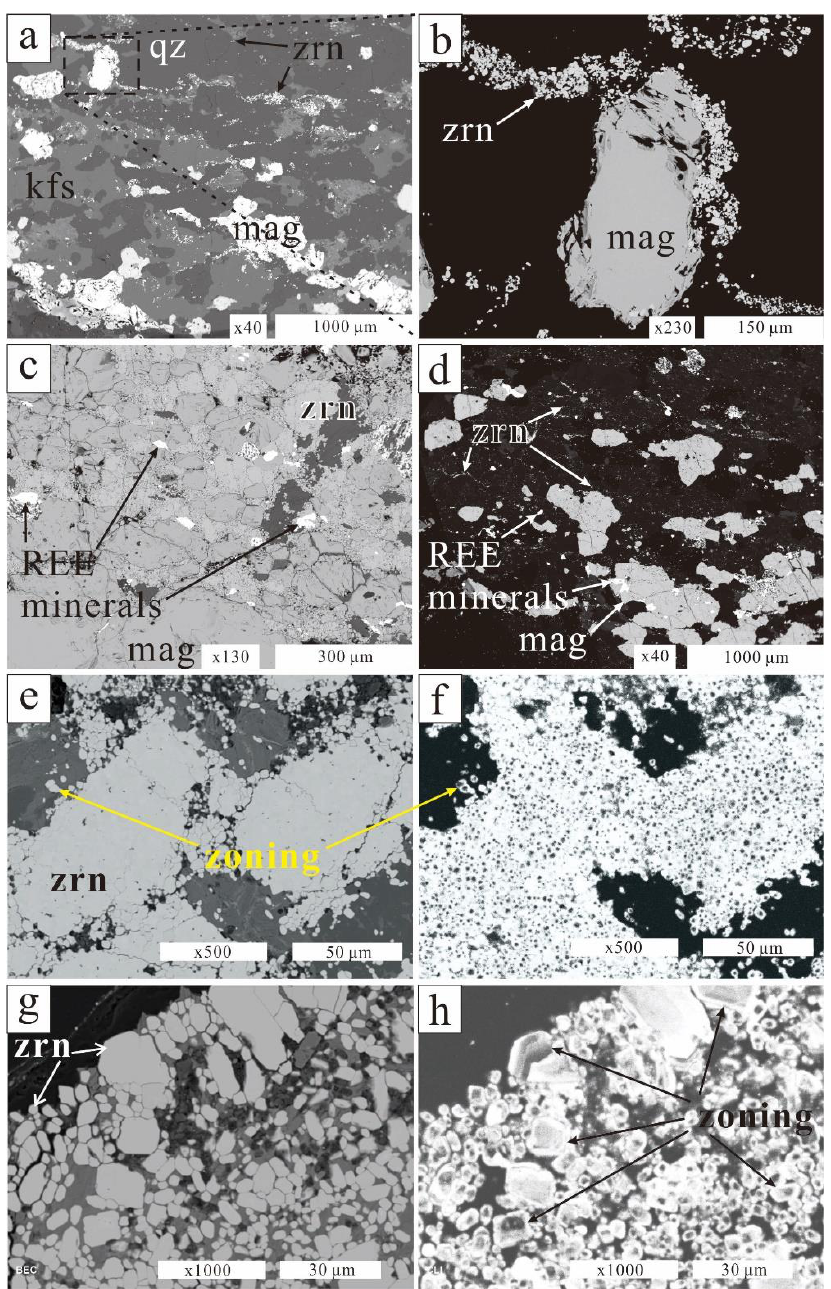
Figure 6. Photomicrographs of zircon aggregate from zircon–allanite–magnetite-rich layers in layered granite and layered aplite. ( a , b ) Back-scattered electron (BSE) images of the zircon–allanite–magnetite layer from layered granite. Note that aggregates of zircon showed crystal settling textures upon magnetite, quartz, and K-feldspar grains. ( c ) BSE image of a zircon–allanite–magnetite-rich layer in layered granite. ( d ) BSE image of alkali aplite showing a linear distribution of zircon grains. ( e ) BSE image of zircon aggregates in a zircon–allanite–magnetite-rich layer. ( f ) Cathodoluminescence (CL) image of same area as in (e), showing euhedral microcrystalline zircon aggregates. Note that zircons showed very fine (several micrometers) oscillatory zoning. ( g ) BSE image of zircon aggregates in a zircon–allanite–magnetite-rich layer. ( h ) Cathodoluminescence (CL) image of same area as in (g), showing euhedral microcrystalline zircon aggregates. Again, zircons showed very fine (several micrometers) oscillatory zoning.